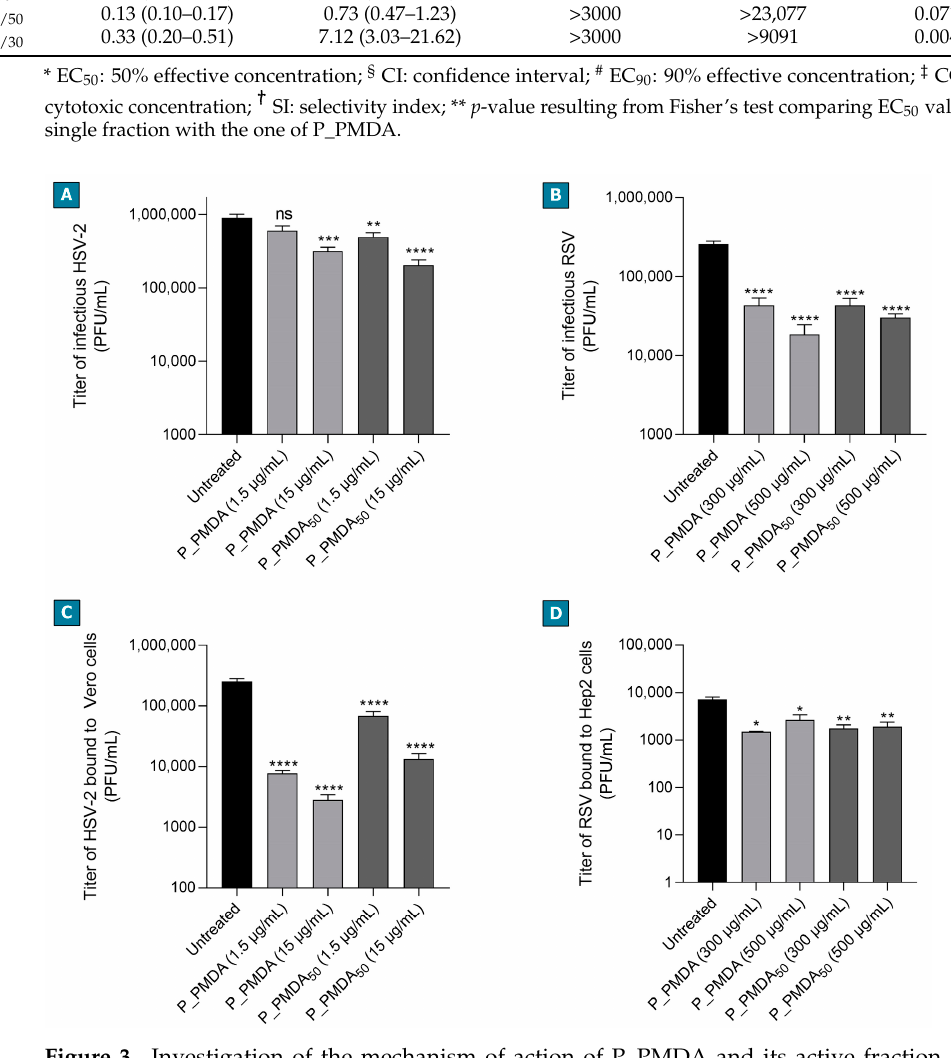
Figure 3. Investigation of the mechanism of action of P_PMDA and its active fraction. HSV-2 ( A ) and RSV ( B ) inactivation assays. HSV-2 or RSV infectious particles were incubated with high concentrations (EC 90 or higher doses) of P_PMDA or P_PMDA 50 for 2 h at 37 °C and the residual viral infectivity was then evaluated by titration to the non-inhibitory concentration of the polymers. For the binding assays, HSV-2 ( C ) or RSV ( D ) (MOIs = 3) were allowed to attach to cells in the presence of the same concentrations of polymers reported for the virus inactivation assays. The cell-bound virus titers were determined by means of titration on confluent cells. On the y-axis, the infectious titers are expressed as plaque-forming units per mL (PFU/mL). Error bars represent standard error of the mean (SEM) of three independent experiments (ANOVA and Bonferroni post hoc test; * p < 0.05, ** p < 0.005, *** p < 0.0005, **** p < 0.0001, ns: not